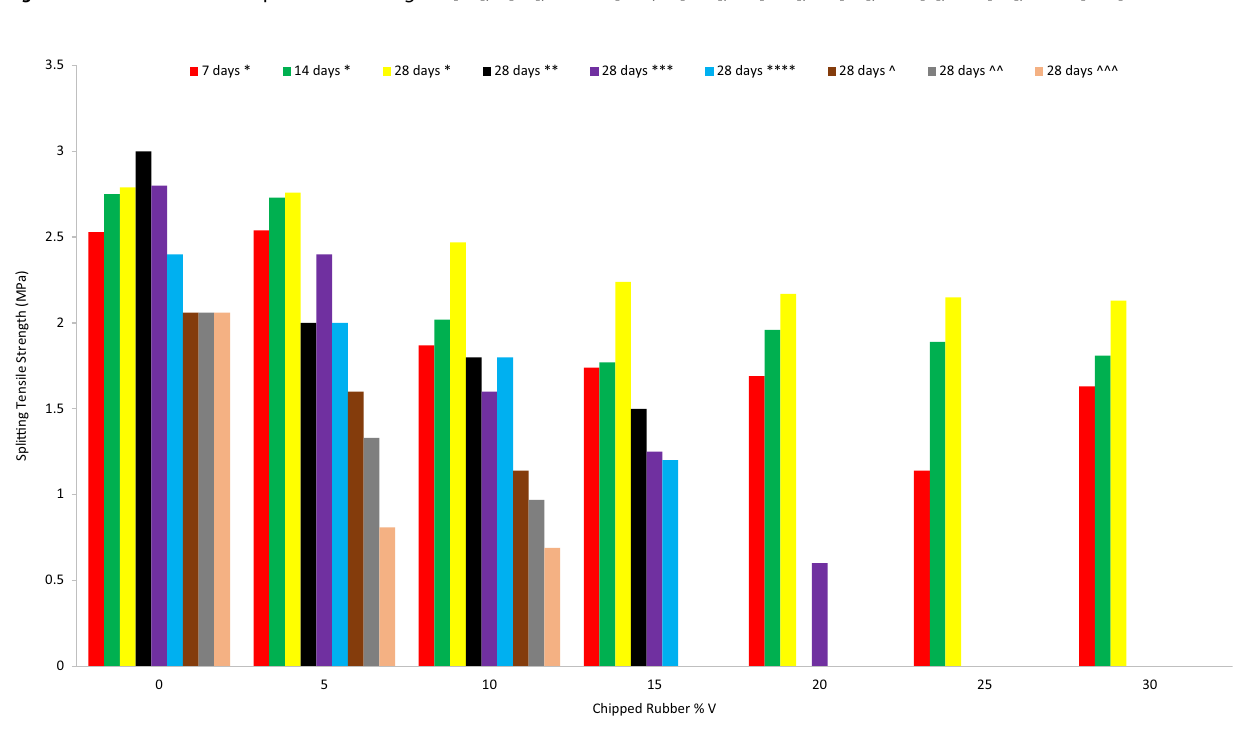
Fig. 14 Chipped Rubbercrete Split Tensile Strength. *[56], ***[115], ^, ^^ and ^^^[114], **[38],